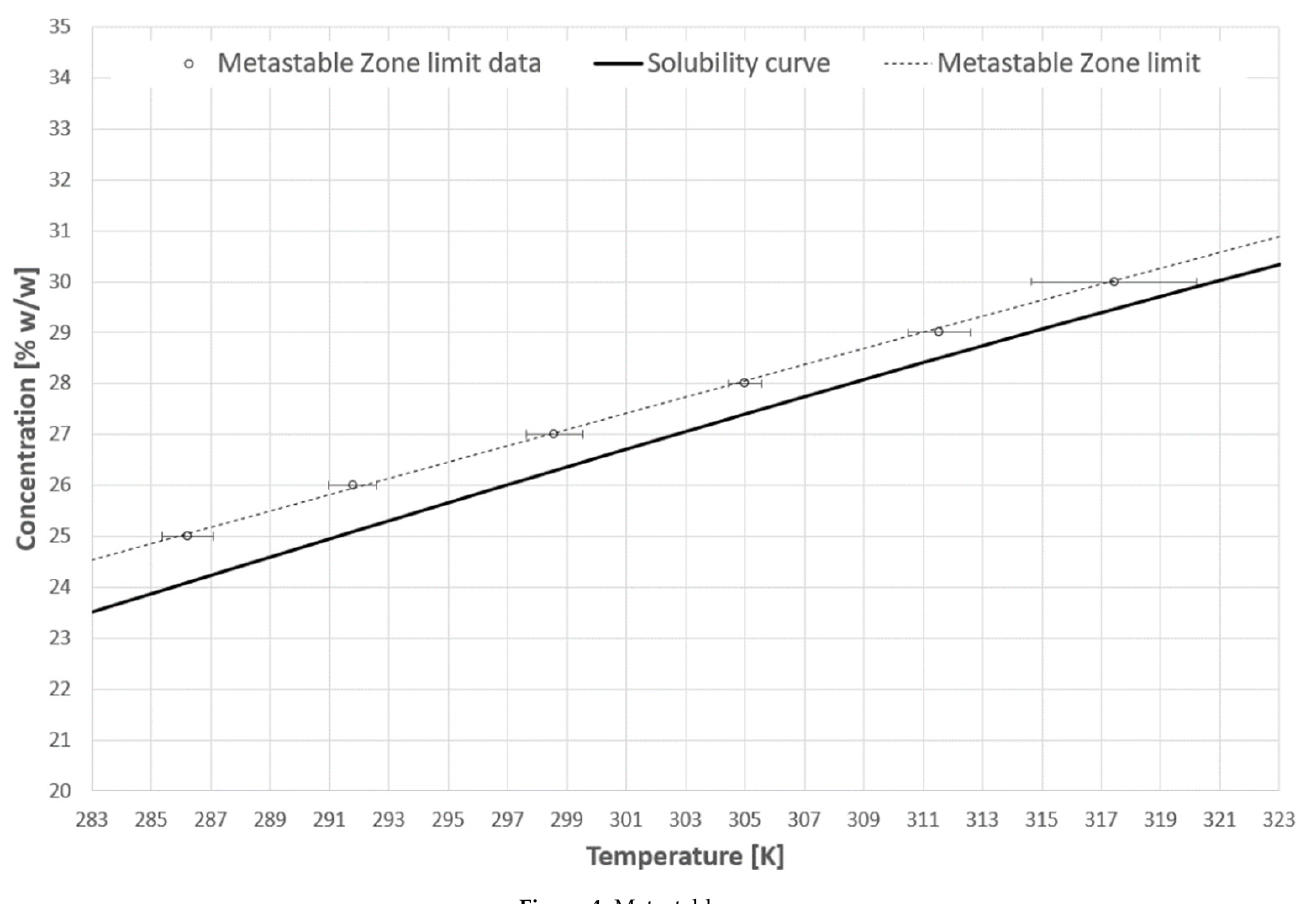
Figure 4. Metastable zone. Table 1. Metastable zone